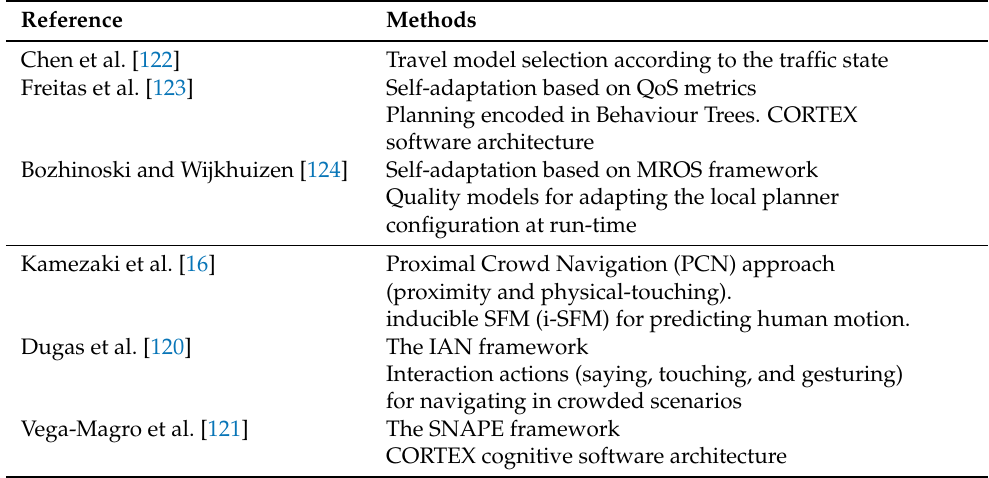
Table 6. Approaches considered in Section 3.4. The table covers multi-behavior navigation approaches and multi-modal behavior navigation